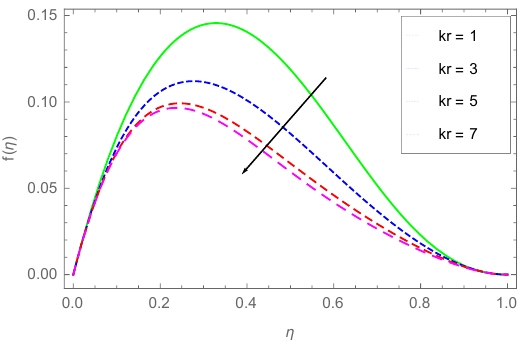
Figure 7. f ( η ) dependence on kr .